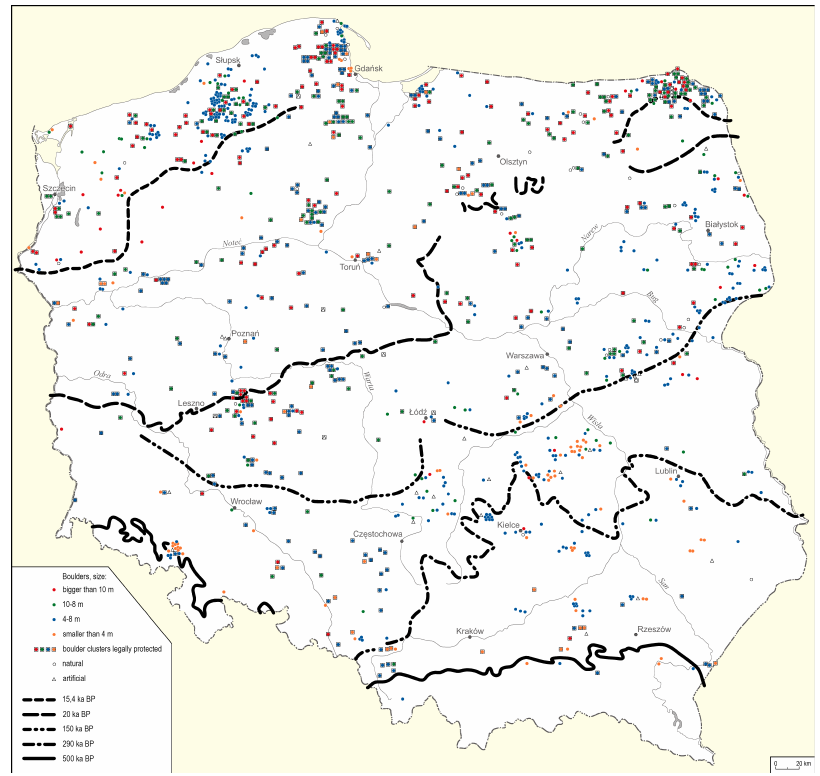
Figure 1. Distribution of erratic boulders in Poland against the ice sheet margins of the Pleistocene glaciations (based upon [105,106]). Note that the course of the ice sheet’s edge represents the state of research from the 1980s (more in the